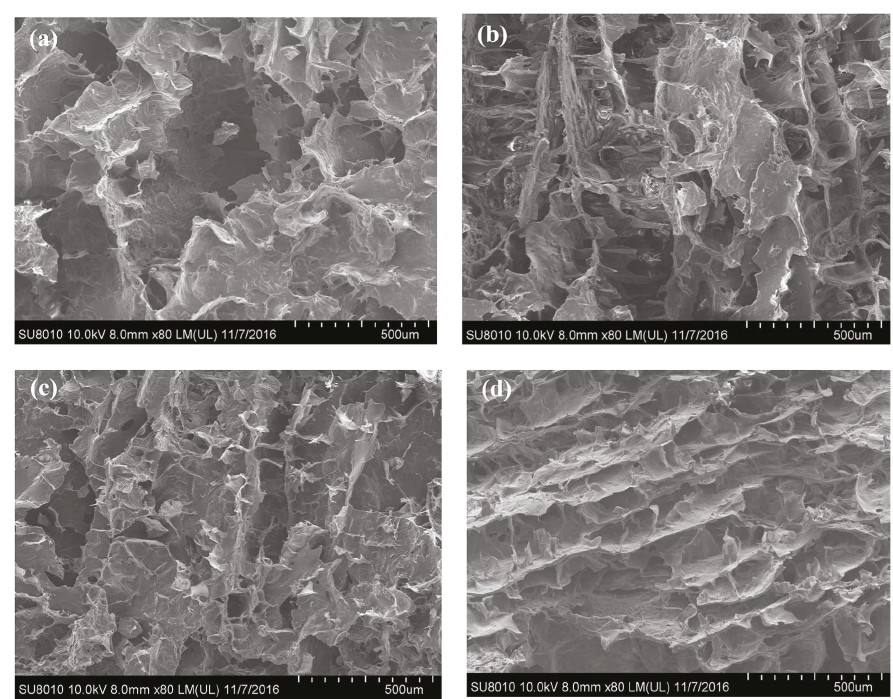
Figure 4: Scanning electron microscopy (SEM) of the restructured carrot-potato chips with different amount of carrot. (a) FD-DIC dried restructured carrot-potato chips with 30% carrot; (b) FD-DIC dried restructured carrot-potato chips with 50% carrot; (c) FD-DIC dried restructured carrot-potato chips with 70% carrot; (d) FD-dried restructured carrot-potato chips with 50%